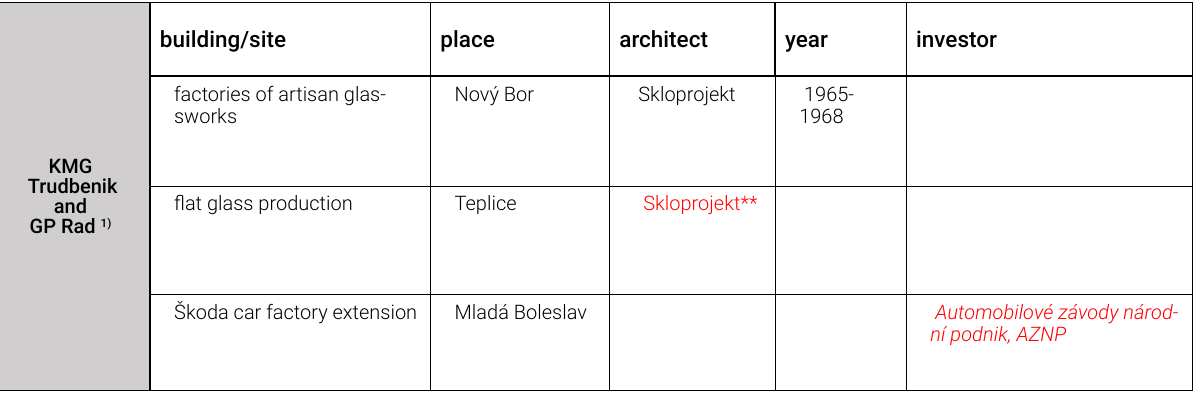
Table 2: Construction Sites of the GP Napred Construction Company